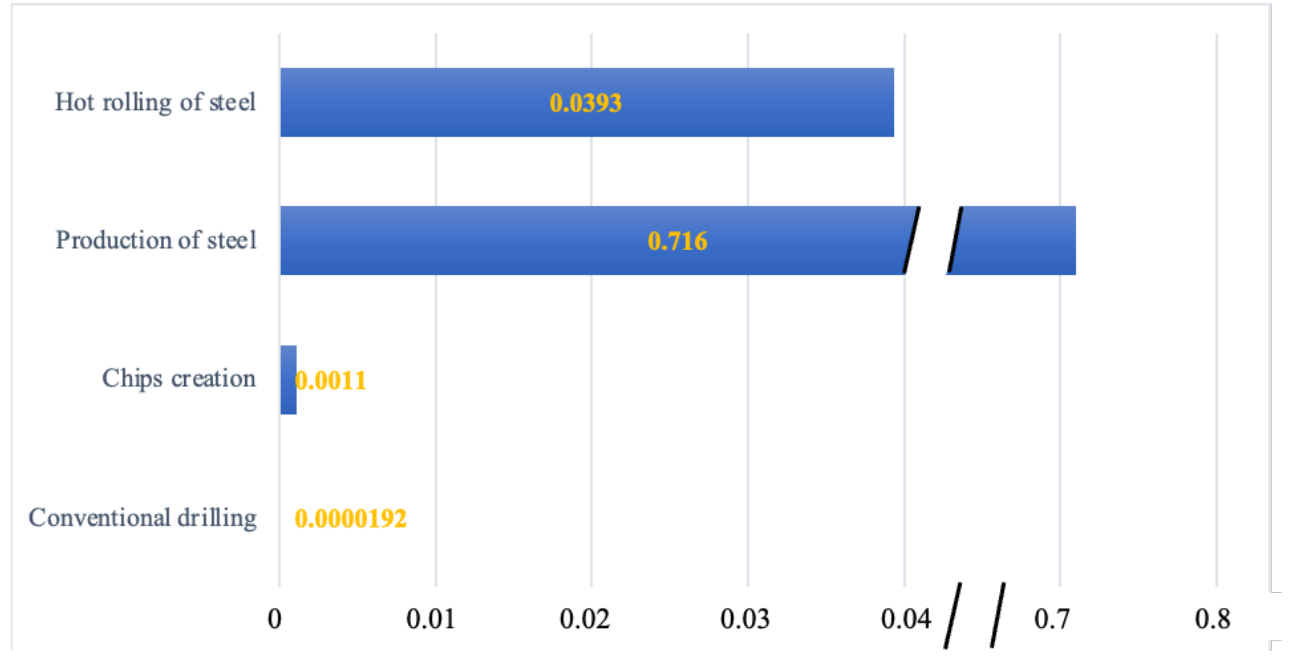
Figure 1. Allocation and values of carbon footprint per step in conventional drilling, showing that the highest value of carbon footprint coming from the production of steel (95%). Table 2. Carbon footprint in kg CO 2 eq for conventional drilling per level, as provided by SimaPro.